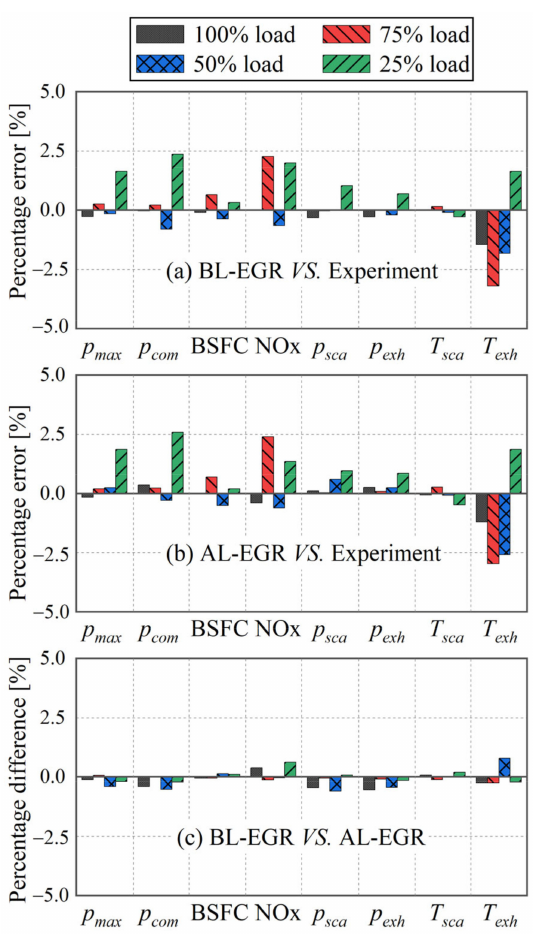
Figure 5. Relative percentage errors of the engine at the Tier II mode: ( a ) between predicted and measured values for the BL-EGR engine configuration; ( b ) between predicted and measured val- ues for the AL-EGR engine configuration; and ( c ) predicted values for the BL-EGR and AL-EGR engine